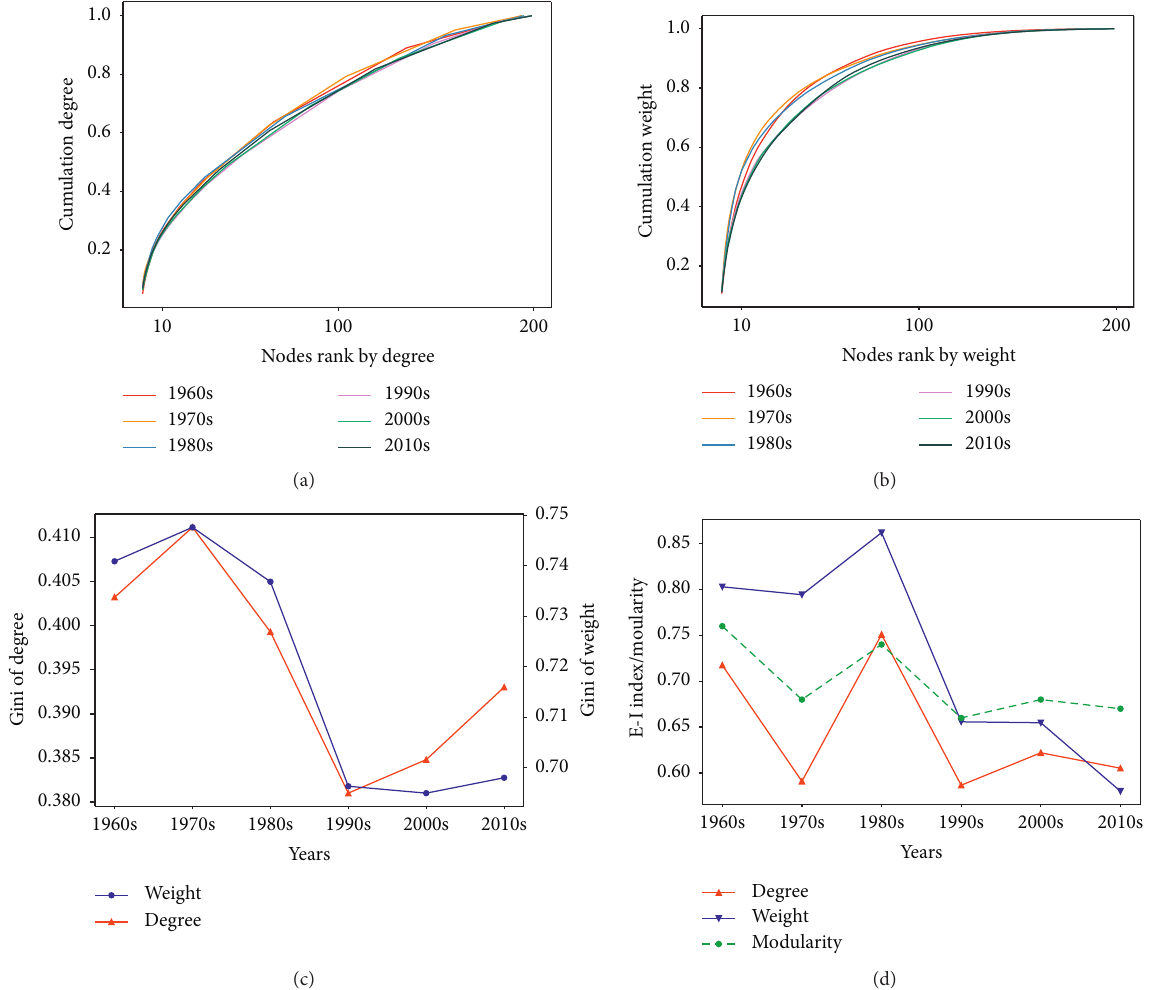
Figure 7: (a) The cumulative distribution of degrees for nodes from 1960 to 2015. (b) The cumulative distribution of weights for nodes from 1960 to 2015. (c) Changes in the Gini index for the degrees and weights from 1960 to 2015. (d) Changes in the E-I index from 1960 to